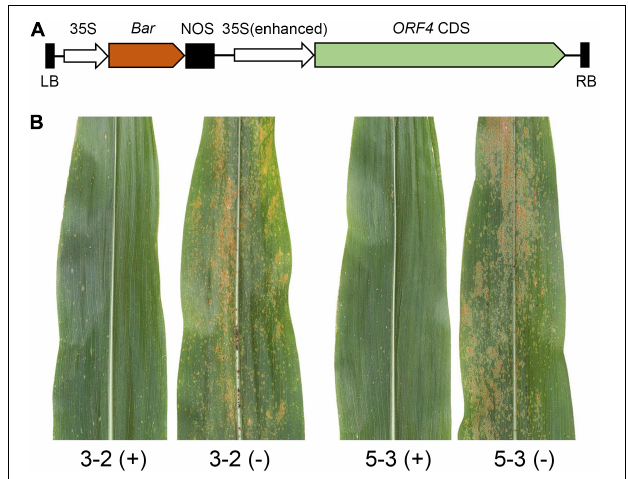
FIGURE 1 | Overexpression analysis of ORF4 . (A) Structure of the ORF4 expression cassette used for Overexpression analysis. The brown arrow presents the Bar gene. LB, left border; RB, right border. (B) Phenotypes of two independent T 1 overexpression lines (3-2 and 5-3) of ORF4